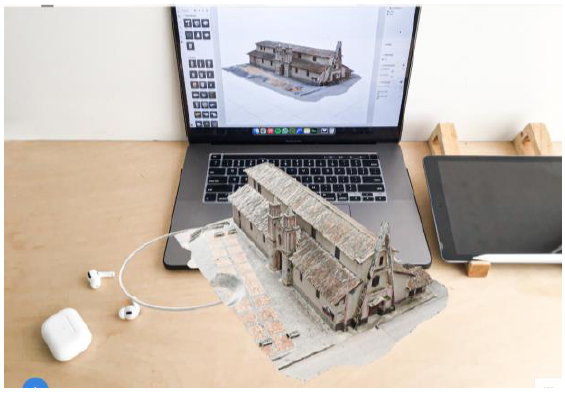
Figure 11 . Nabón’s church in augmented reality (AR)